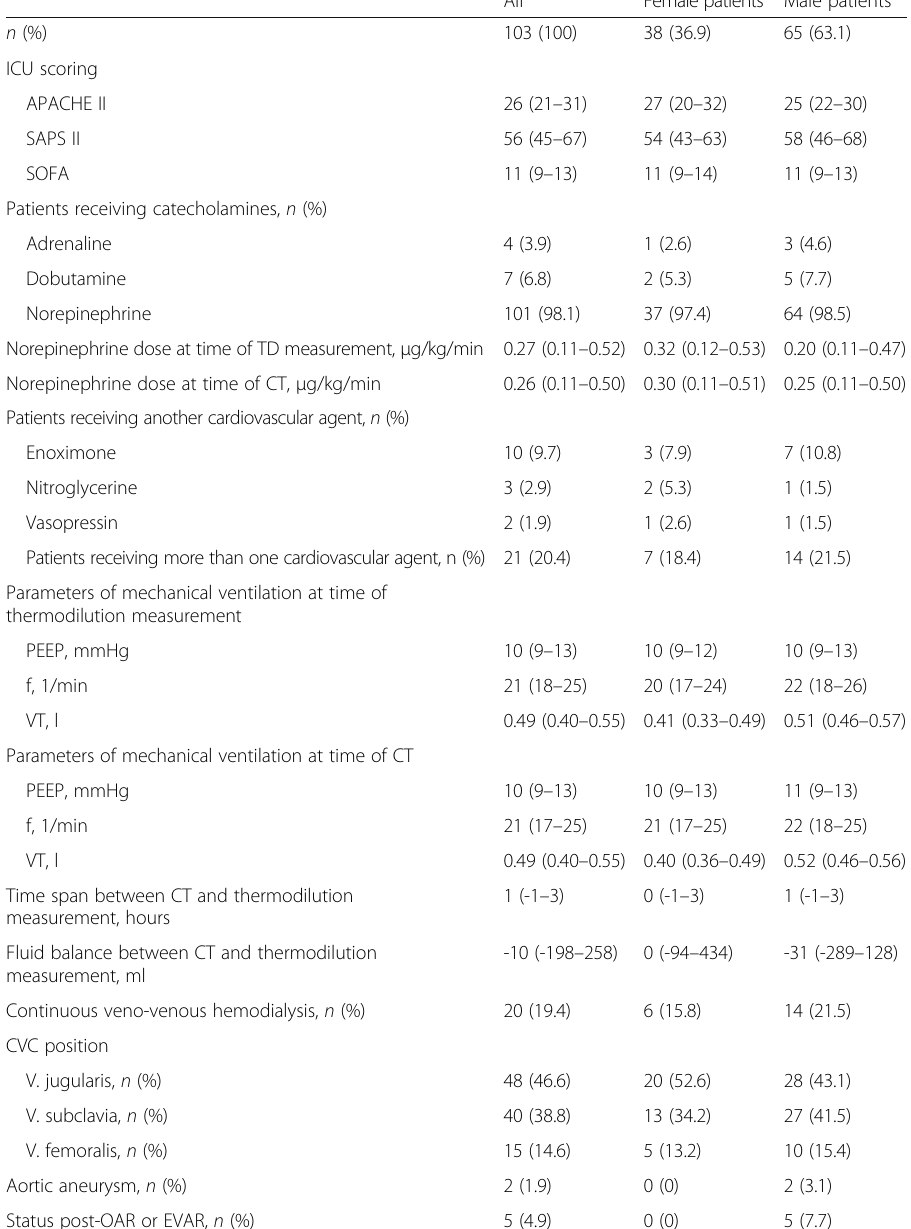
All Female patients Male patients